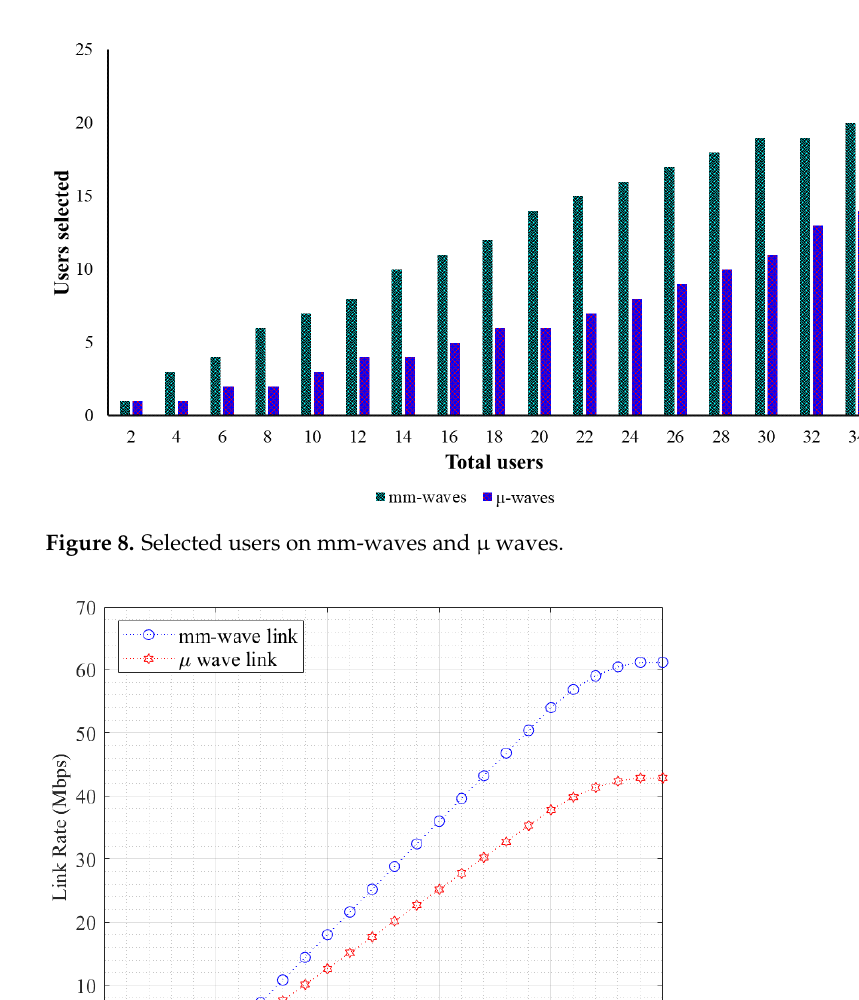
Figure 7. The number of users vs. corresponding average energy efficiency.